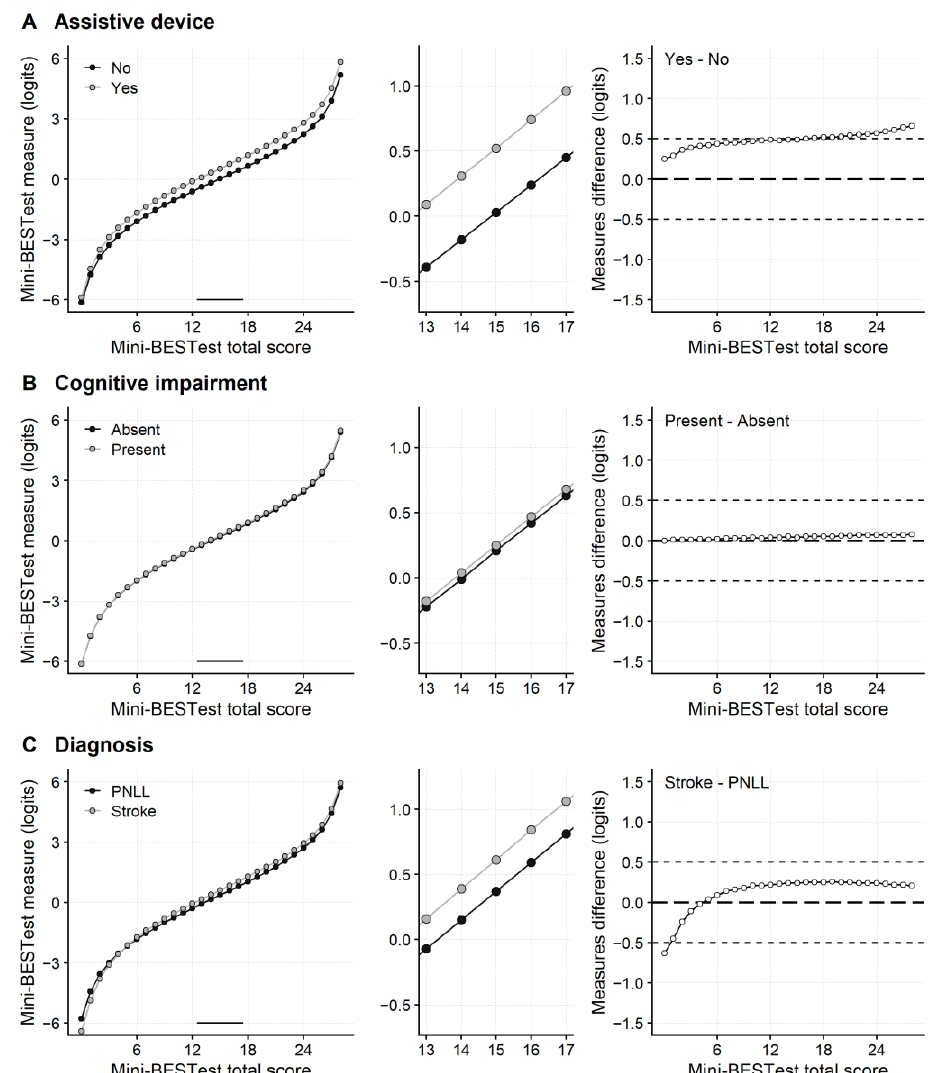
Figure 1. Differential Item Functioning of the Mini-BESTest scale. The artefact caused by the differential item functioning (DIF) on the Mini-BESTest measures has been studied by comparing the score-to-measure curves. DIF was found for assistive device use ( A ), cognitive impairment ( B ), and diagnosis (stroke vs. peripheral neuropathy of the lower limbs, PNLL) ( C ). The group-specific score-to-measure curves are shown in the leftmost plots. The middle graphs magnify the portion of the score-to-measure curves marked by a horizontal segment in the score-to-measure plots. The rightmost graphs show the difference between the two score-to-measure curves ( y -axis) for each value of the Mini-BESTest total score ( x -axis). This difference was about 0.5 logits (thin dashed horizontal lines) or larger for most of the Mini-BESTest scores in the case of DIF for assistive devices. In the case of DIF for diagnosis, the difference between the two score-to-measure curves was >0.5 only for a total score equal to 0.